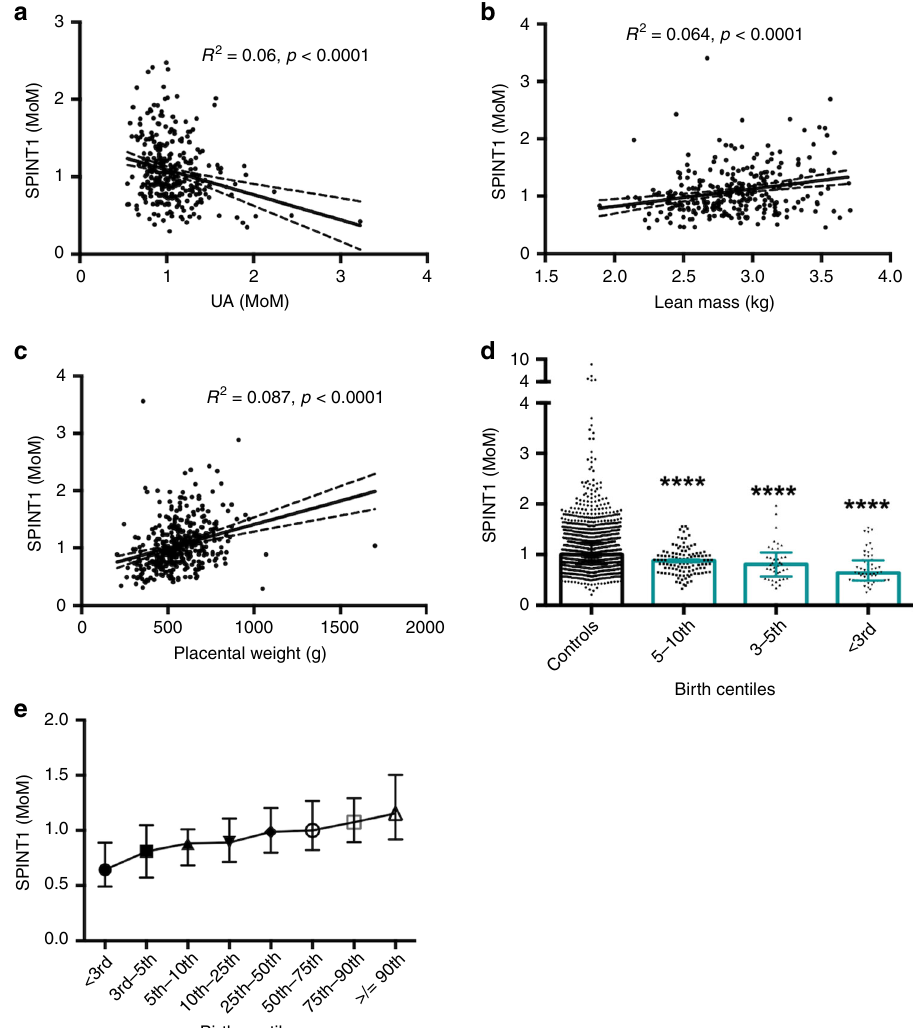
Fig. 2 Plasma SPINT1 at 36 weeks is associated with clinical markers of placental insuf fi ciency. Plasma SPINT1 concentrations at 36 weeks ’ gestation were correlated with uterine artery (UA) Doppler fl ow resistance ( a , n = 327), lean mass of the neonate ( b , n = 281), and placental weight ( c , n = 305). There was a step-wise reduction in plasma SPINT1 concentration in women whose babies were subsequently born with a birthweight below the 10th centile ( d , n = 1803 controls, 5 – 10th n = 115, p = 9.63 × 10 − 8 vs control, 3 – 5th n = 42, p = 8.57 × 10 − 5 vs control, <3rd n = 54, p = 3.06 × 10 − 12 vs control). Plasma SPINT1 concentrations at 36 weeks were correlated with birth centiles ( e ). SPINT1 MoMs were combined for both cohort 1 and 2 and grouped according to the birth centile. Graphs d and e depict median + / − interquartile range. Each individual symbol ( a – c ) represents a patient. **** p < 0·0001 relative to control (two-tailed Mann – Whitney U tests). Source data included as a Source Data fi